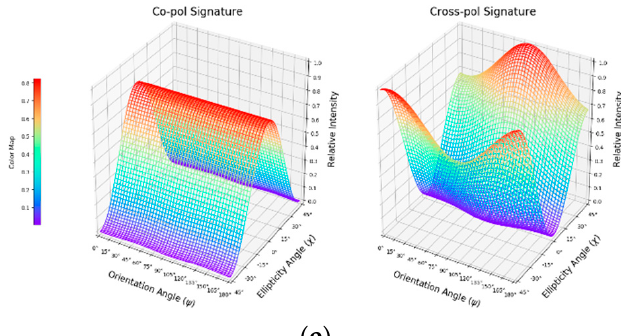
Figure 5. The L-band polarimetric signatures for ( a ) CR 23, ( b ) CR 24, ( c ) CR 25, ( d ) CR 26, and ( e ) CR 27.